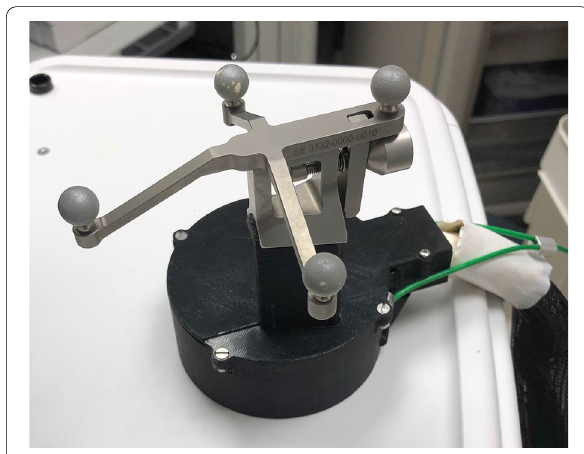
Fig. 1 Handheld SiPM gamma camera with four reflecting spheres